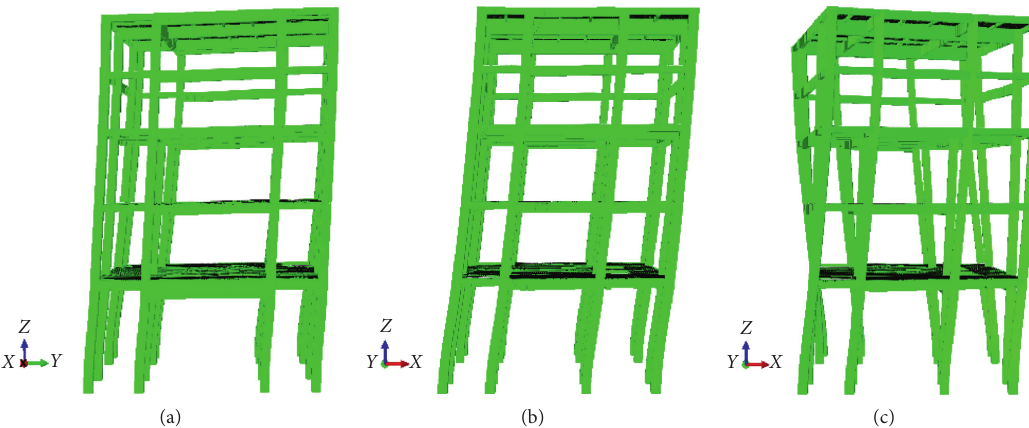
Figure 3: First three modes of the structure. (a) First modal shape, (b) second modal shape, and (c) third modal shape.